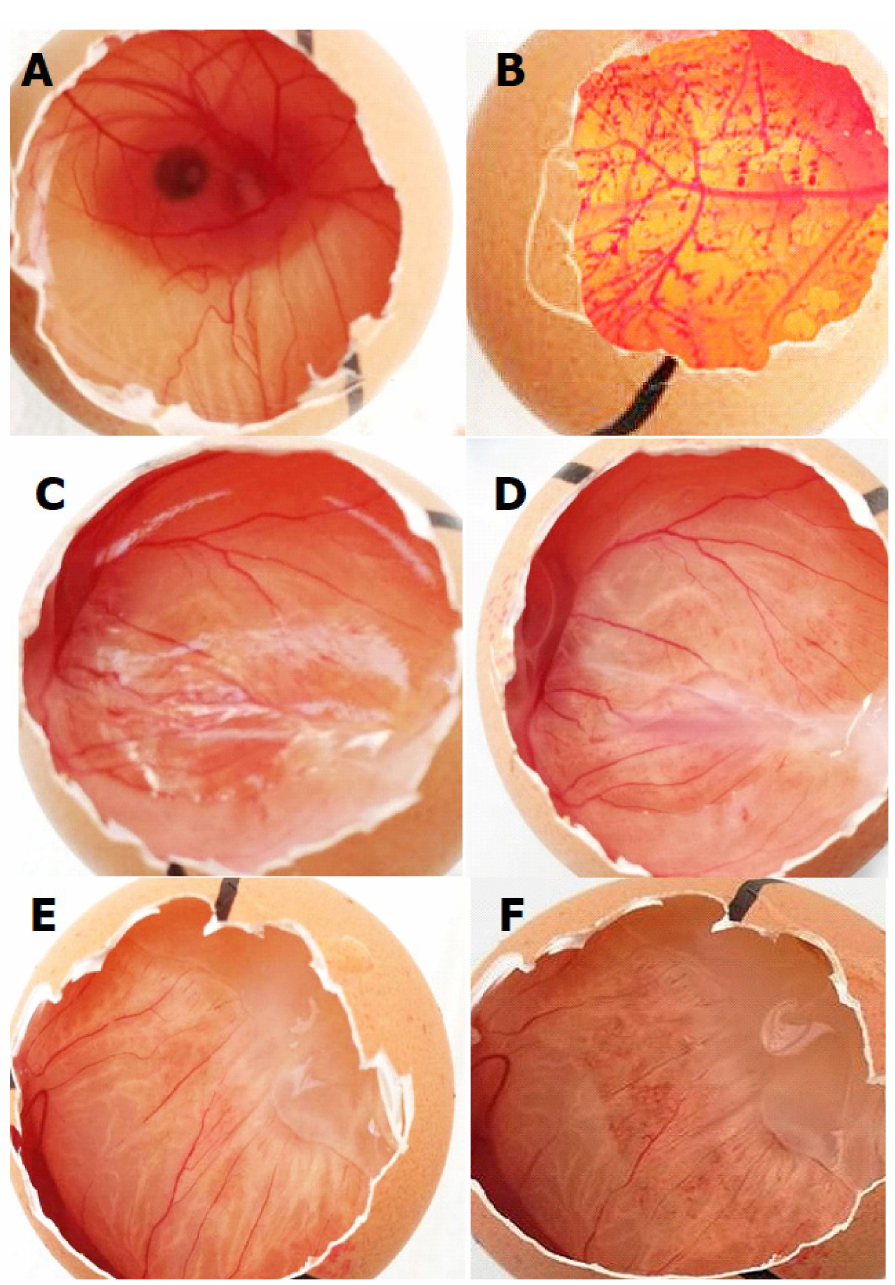
Figure 11. Effects of the particulate systems on the chorioallantoic membrane: ( A ) negative control; ( B ) positive control; chorioallantoic membrane before ( C ) and after ( D ) application of PE2-A-HA- Cs-Dexamethasone; chorioallantoic membrane before ( E ) and after ( F ) application of PE2-A-HA-Cs- Bevacizumab (2 ×